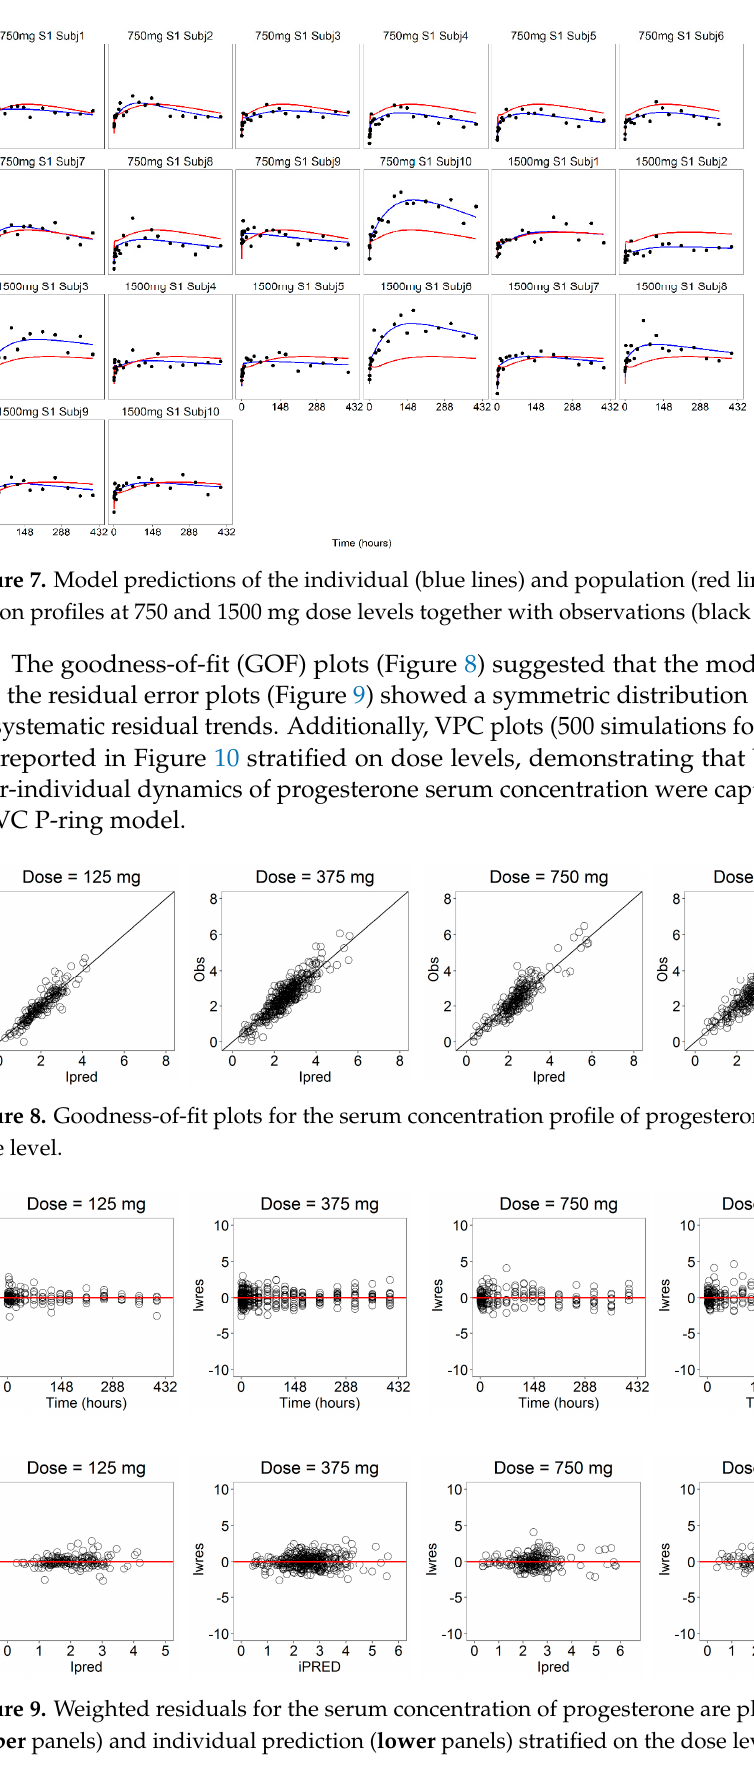
Figure 6. Model predictions of the individual (blue lines) and population (red lines) serum con- centration profiles at 125 and 375 mg dose levels together with observations (black dots).